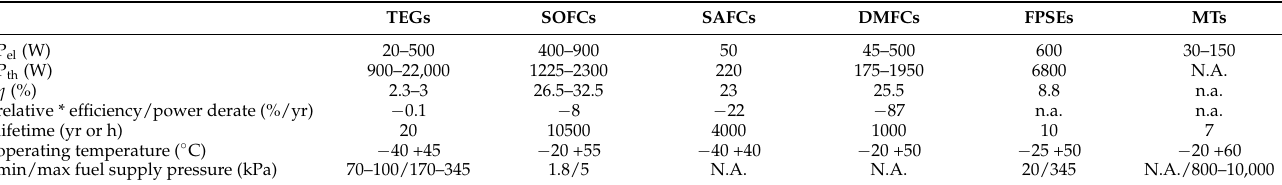
Table 2. Technical features of TEGs, SOFCs, SAFCs, DMFCs, FPSEs and